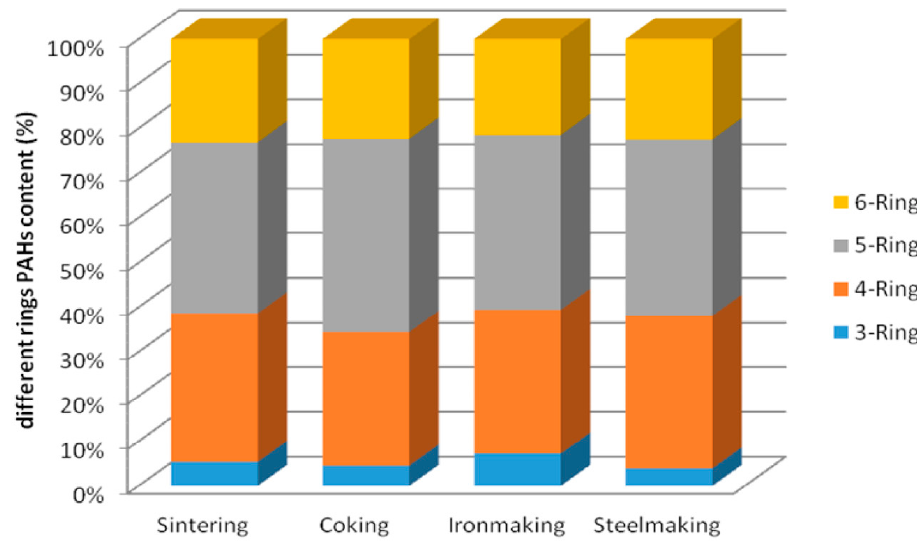
Figure 2. The distribution pattern of rings numbers of PAHs concentration in different processes dust dust emission.